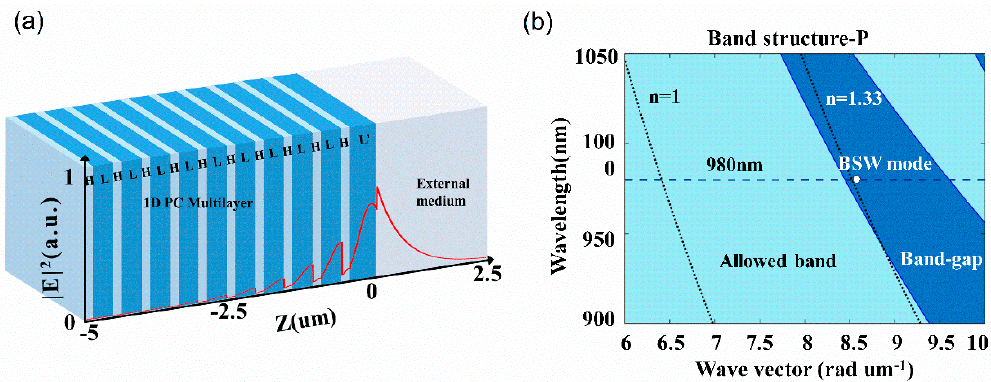
Figure 2. ( a ) Schematic of the BSW sensor and the normalized electric field distribution of the excited BSW; ( b ) Simulated band structure of the 1D PC structure for P polarization and the BSW mode excited. The light blue region is the allowed band and the dark blue region is the band-gap. Dotted lines are light lines for air ( n = 1) and water ( n = 1.33) respectively.